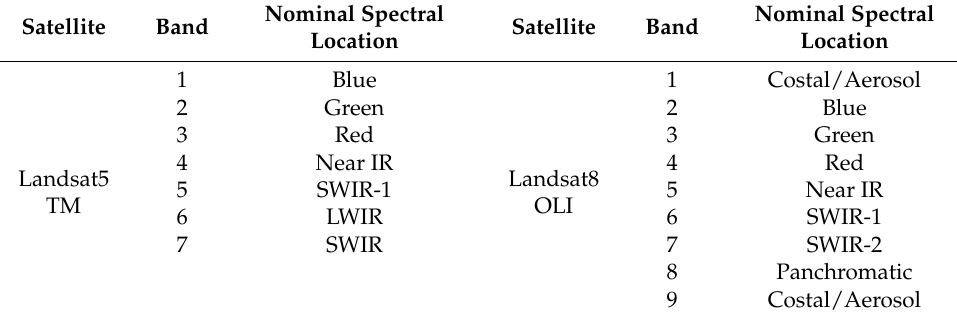
Table 1. Landsat5 TM/8 OLI data